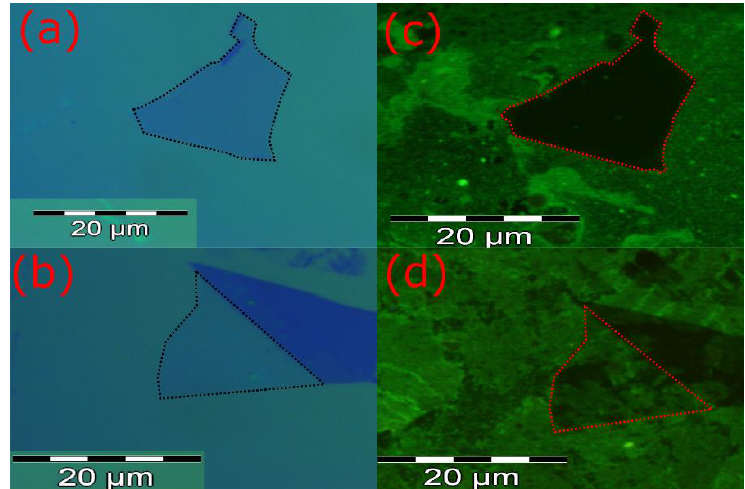
Figure 4. Optical microscope images of graphene flakes ( a ) without PBSE and ( b ) with PBSE, both on top of a SiO 2 /Si substrate. ( c , d ) Fluorescence images of the flakes after incubation in a solution of antibodies labeled with fluorescein isothiocyanate (FITC).